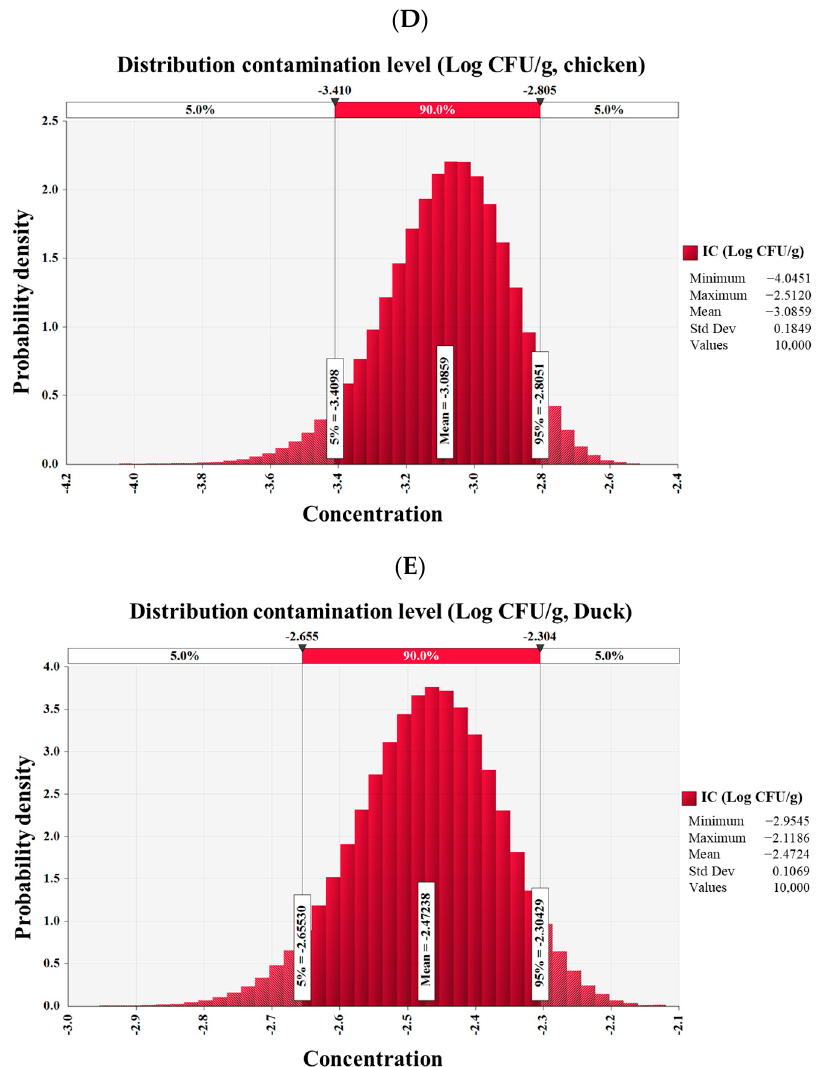
Figure 2. Probability of Salmonella contamination in farm-to-retail chicken and duck. ( A ) Salmonella contamination in farm feces. ( B ) Salmonella contamination in cecal contents of slaughterhouse. ( C ) Changes in Salmonella contamination levels by slaughterhouse stage. ( D ) Salmonella contamination levels in chicken at the distribution stage. ( E ) Salmonella contamination levels in duck at the distribution stage.